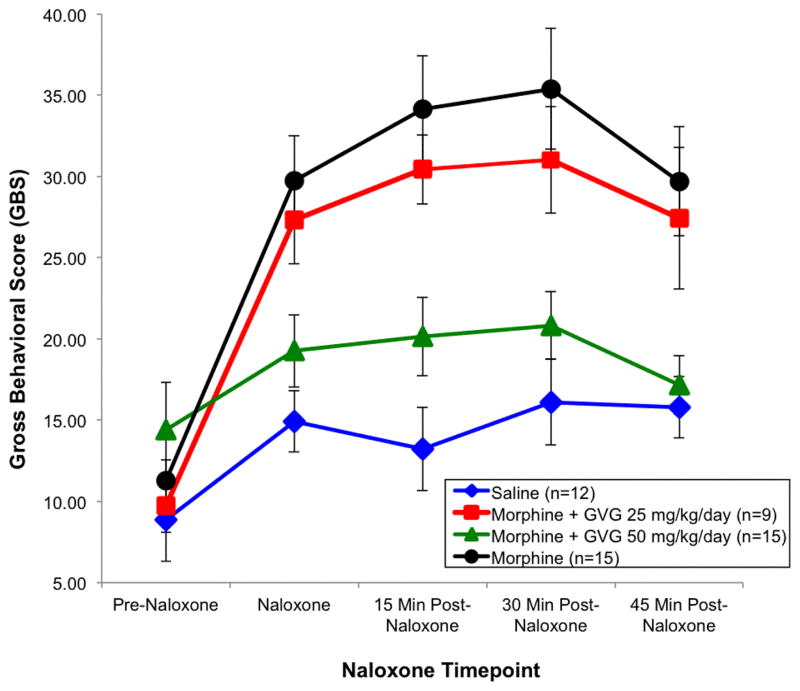
Withdrawal behaviour vs. naloxone time point, Intensity of withdrawal before and after naloxone administration.